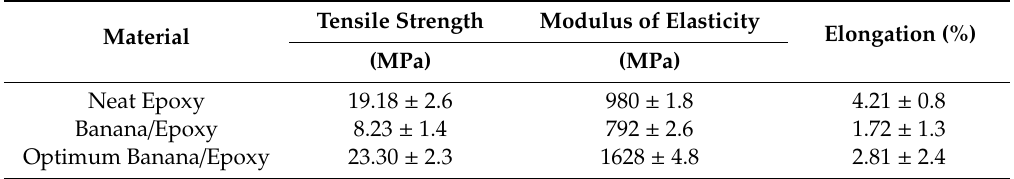
Table 2. The average and standard deviation values of the modulus of elasticity, tensile strength, and percentage elongation of the virgin epoxy and natural fiber composites.